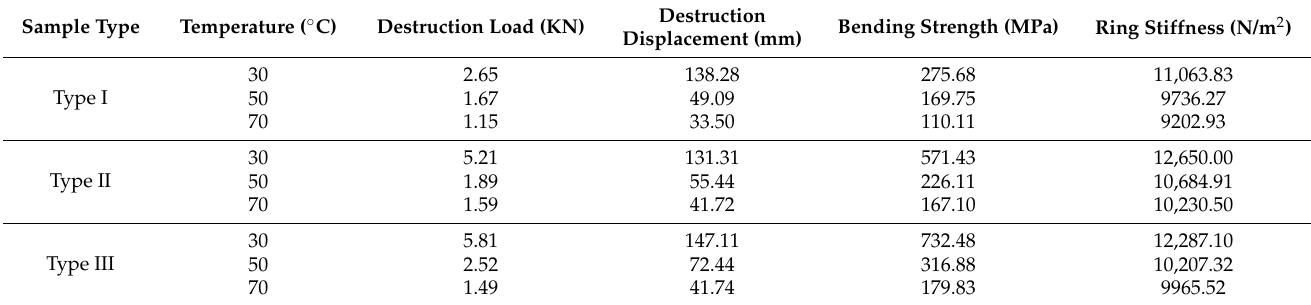
Table 2. Experimental data results of GFRP pipes.